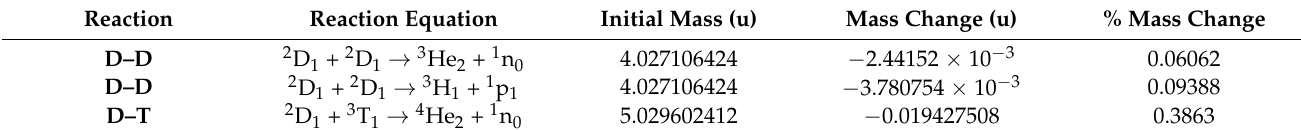
Table 2. Mass conversion factors for fusion reactions between various isotopes of hydrogen. Reaction